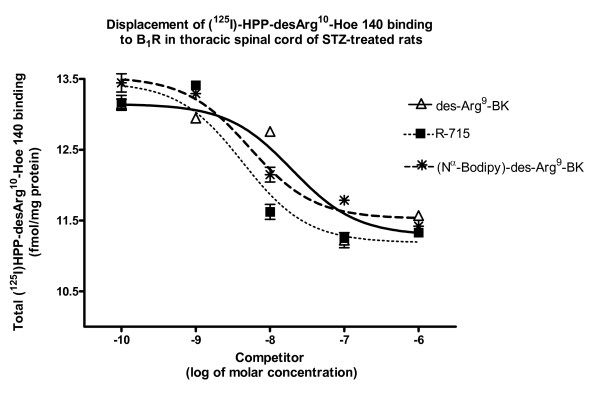
[Nα-Bodipy]-des-Arg9-BK selectivity for B1R was evaluated by quantitative autoradiography. R-715 (selective B1R antagonist), des-Arg9-BK (selective B1R agonist) and [Nα-Bodipy]-des-Arg9-BK (fluorescent agonist of B1R) displaced in a concentration-dependent manner, from 10-10 to 10-6 M, the total binding of 200 pM [125I]-HPP-desArg10-Hoe 140 to B1R. Data are means ± SEM of 4 sections per rat from 7 different rats for each compound.